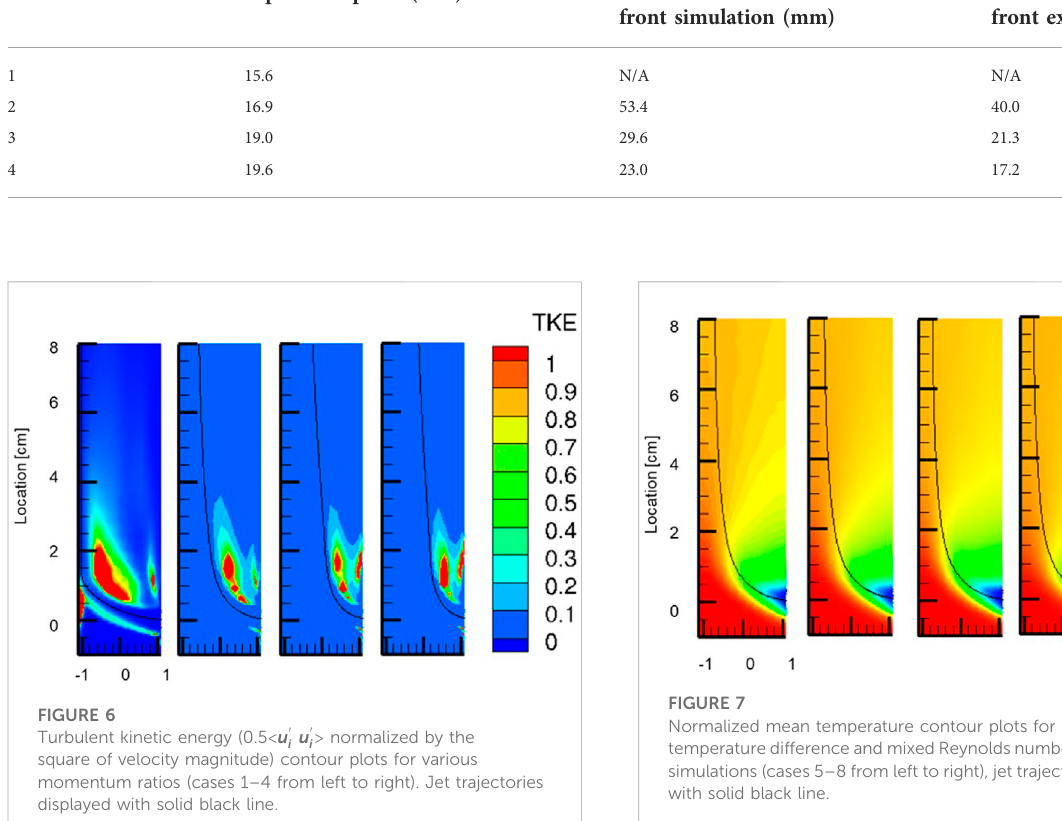
TABLE 3 Locations of the separation point and the thermal front for Cases 1 – 4. Case no.